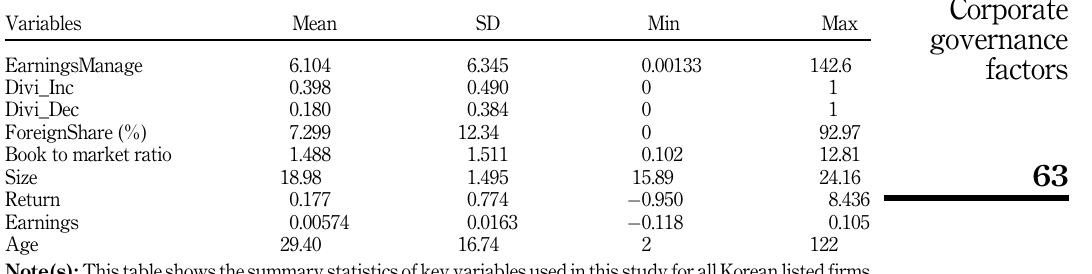
Table 1. Summary